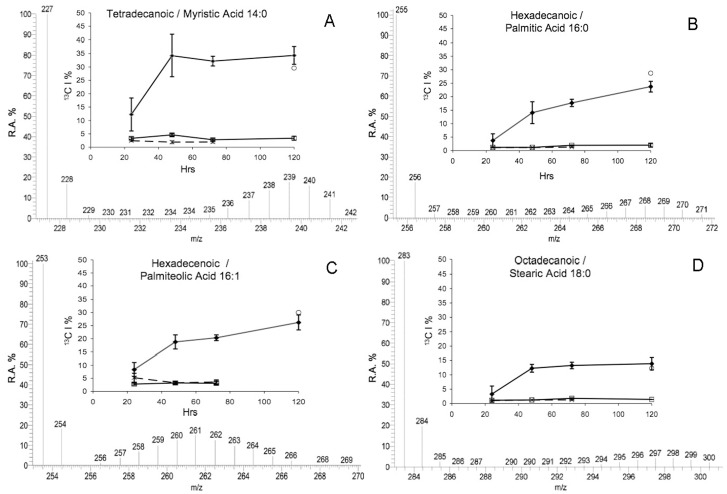
Isotopic incorporation lipid profiles of fatty acids in symbiotic A. pulchella.Subplots: Relative Amount (R.A.) of 13C incorporation (13C I) into the FA structures (%) over time. Key: R.A.%  =  Relative Abundance of isotopologues, m/z  =  Mass-to-Charge ratio of isotopologues, 13CI %  =  Isotopic incorporation in isotopologues, ⧫  =  DI13C ASW treated symbiotic anemones (n = 5), Square symbol  =  DI13C ASW treated aposymbiotic anemones (n = 3), X  =  Non-isotopic DIC ASW treated symbiotic anemones (n = 5), Circle symbol  =  DI13C ASW Dinoflagellates expelled from treated symbiotic anemones (combined from treatment over time). Error Bars  =  Standard Deviation. Note: Where data not shown for time points  =  Signal was below detection. Spectrum data shown is from DI13C ASW symbiotic anemones at 72 hr.